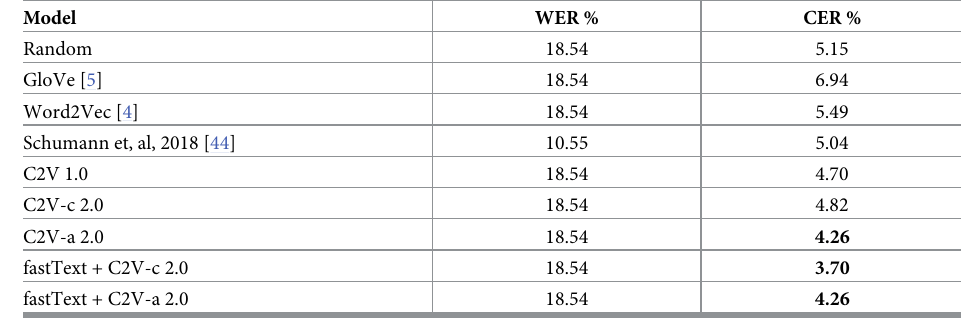
Table 5. Intent Classification Error Rates (CER): Trained and evaluated on noisy ASR